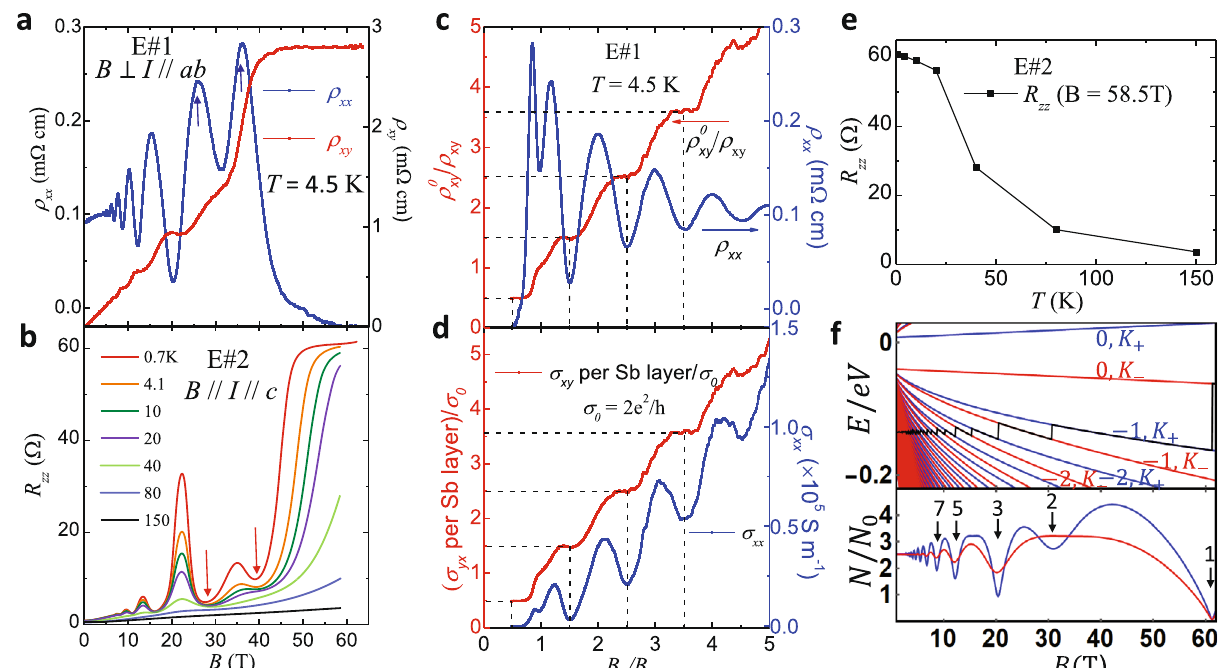
Fig. 4 Bulk quantum Hall effect in Eu-doped BaMnSb 2 . a Magnetic fi eld dependences of ρ xx and ρ xy of the Hall bar sample E#1, measured with fi eld perpendicular to the Sb-plane up to 64 T (see Supplementary Note 5 and Fig. 11). The arrows indicate the oscillation peak splitting in ρ xx . b Magnetic fi eld dependence of R zz at various temperatures ( T = 0.7, 4.1, 10, 20, 40, 80, and 150 K), measured on another Eu-doped sample (E#2) with a similar composition. The red arrows indicate the splitting in an oscillation valley. c Normalized inverse Hall resistivity ( ρ 0 xy = ρ xy ) and in-plane resistivity ( ρ xx ) versus B = B for sample E#1. d The Hall conductivity σ yx per Sb layer normalized by 2 e 2 / h , and longitudinal conductivity σ xx as a function of B F Temperature dependence of R zz at 58.5 T for sample E#2. f The LLs calculated from the effective model around K blue and red lines, respectively. The black line is E F . Bottom panel in f : The DOS at E F with Gaussian disorder broadening Γ 0 ¼ 2 meV (blue) and Γ 0 ¼ 3 meV (red) 23 . The numbers above the black arrows label the LL fi lling at DOS